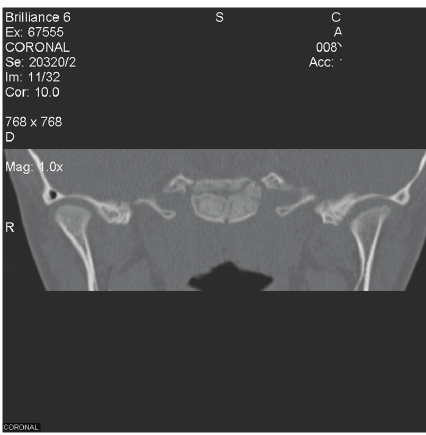
Figure 4: Coronal sectional CT showing flattening of the left